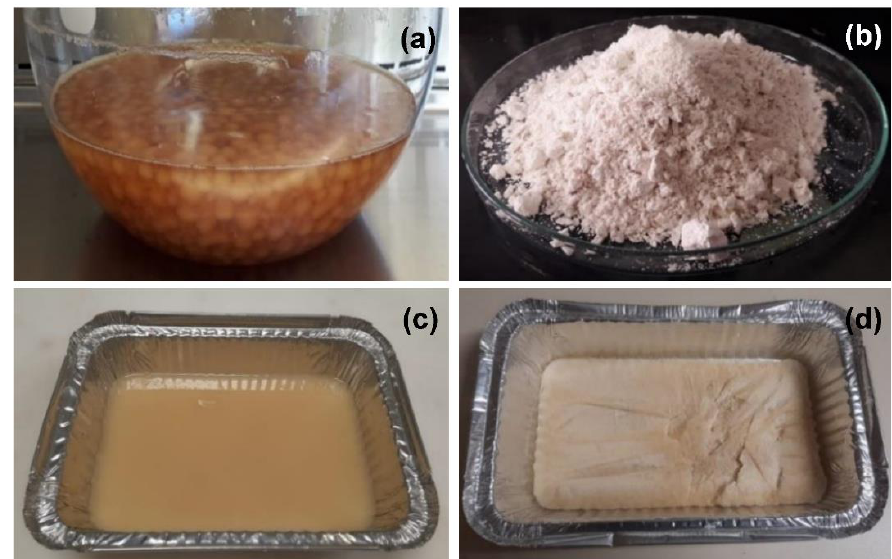
Figure 1. Production of biomass powder and protein isolate: ( a ) fresh biomass; ( b ) freeze-dried biomass powder; ( c ) protein isolate solution; ( d ) freeze-dried protein isolate.